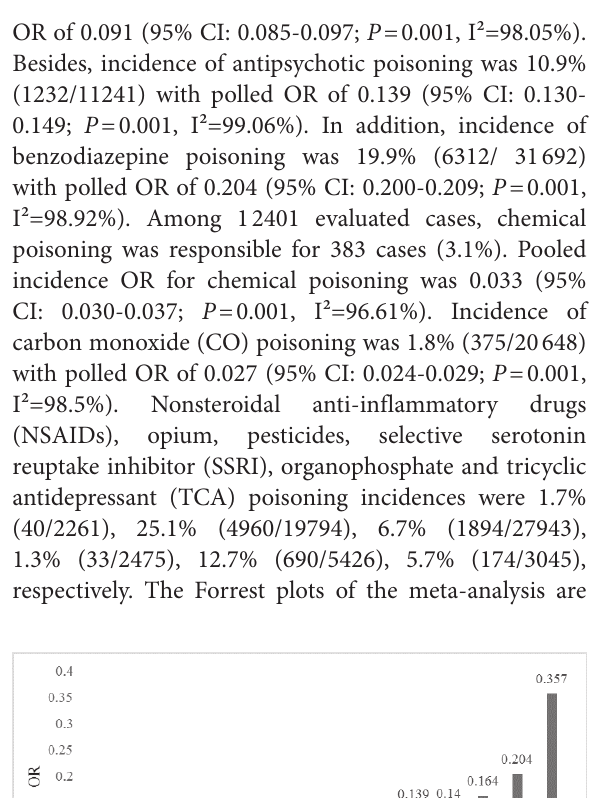
Figure 2. Ranking of each poisoning agent Figure 1 . Study search strategy (PRISMA flow diagram).